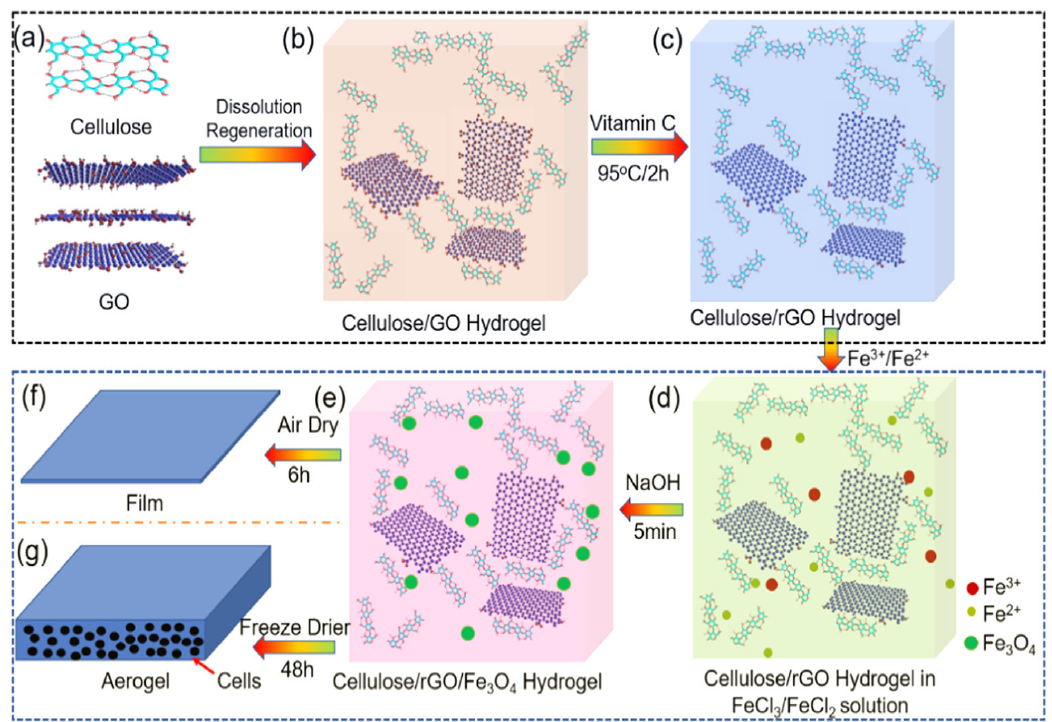
Figure 16. ( a – g ) Stepwise demonstration of the preparation of cellulose/rGO/Fe 3 O 4 composite hydrogels, aerogels and films via freeze-drying and air-drying, respectively. Reproduced with permission from [156]. Copyright 2020, American Chemical Society.